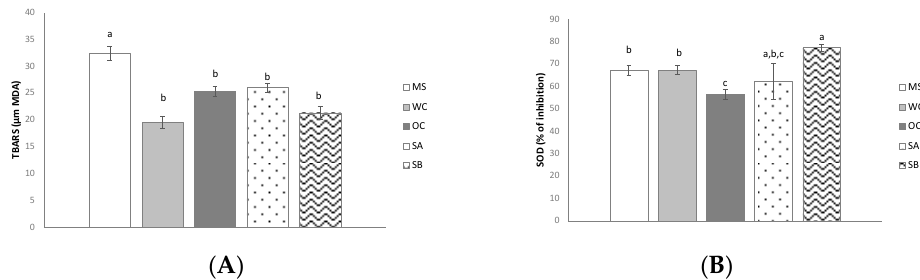
Figure 1. Effects on oxidative stress of MetS rats (MS), rats with fed with wheat control diet (WC, n = 10), wheat and oat control diet (OC, n = 10), A snack (SA, n = 10), and B snack (SB, n = 10). ( A ) TBARS activity and ( B ) SOD activity. Values are expressed as mean ± SEM. Values not sharing a common letter are significantly different ( p < 0.05).